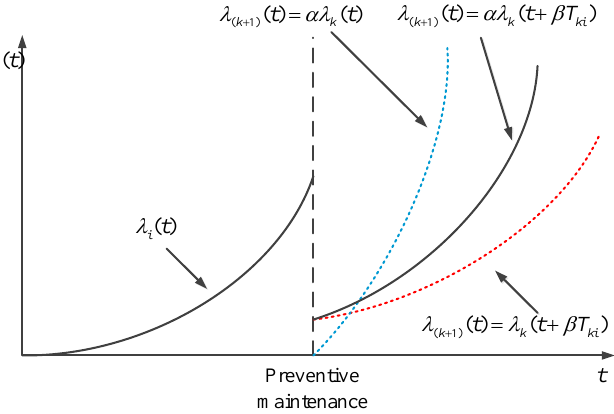
Figure 3. Failure chain model.